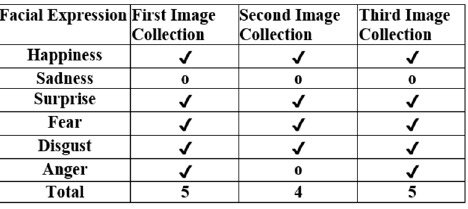
Figure 5. Assessment form.